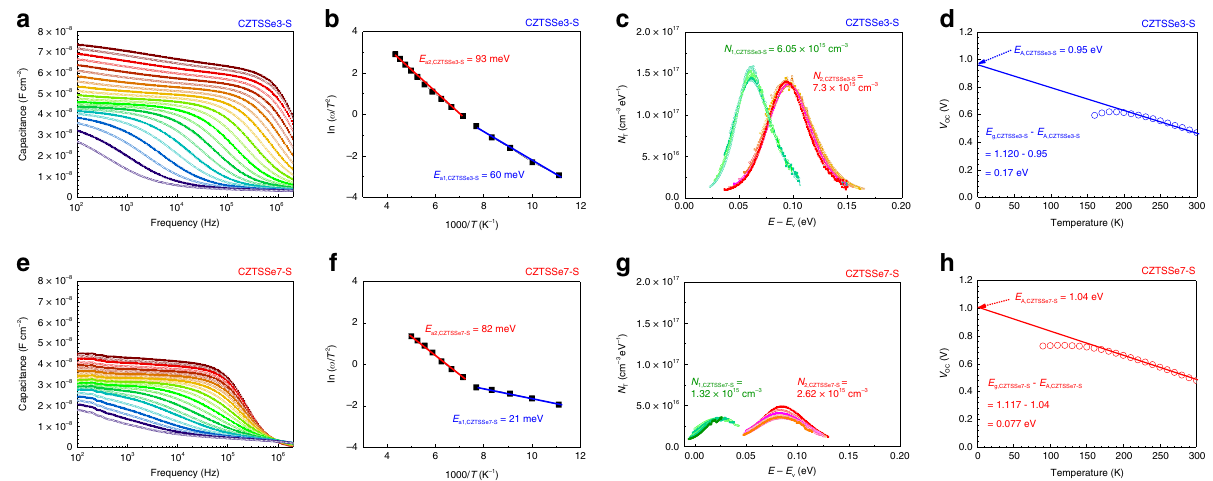
Fig. 2 Defect activation energies of fl exible CZTSSe3-S and CZTSe7-S. (Supplementary Figs. 3 – 6) a , e Admittance spectra measured in the temperature range of 90 – 300 K using probe frequencies from 20 Hz to 2 MHz. b , f Arrhenius plots of the in fl ection points of the capacitance function calculated from derivatives of the AS measurements. E a denotes the main defect energy level within the absorber layer. c , g Concentrations of recombination centers (defect densities, N ) derived from a and e . d , h Temperature dependence of V OC . The values of E A for CZTSSe3-S and CZTSSe7-S are 0.95 and 1.04 eV, respectively. The values of E g − E A for CZTSSe3-S and CZTSSe7-S are 0.17 and 0.077 eV, respectively